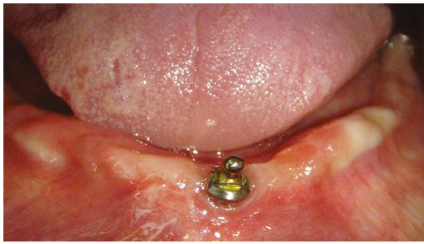
Figure 6: Acceptable soft tissue health with no mucosal enlarge- ment around the retentive anchor at 12-month recall.